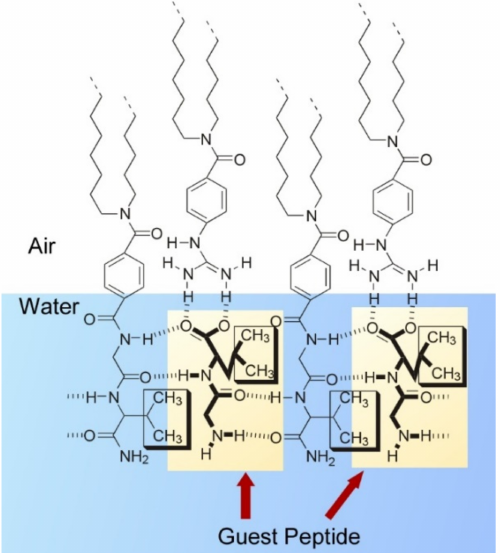
Figure 14. Monolayers of simple dipeptide molecules with hydrophobic tails at the air–water interface forming molecular-size spaces for specific recognition of aqueous guest